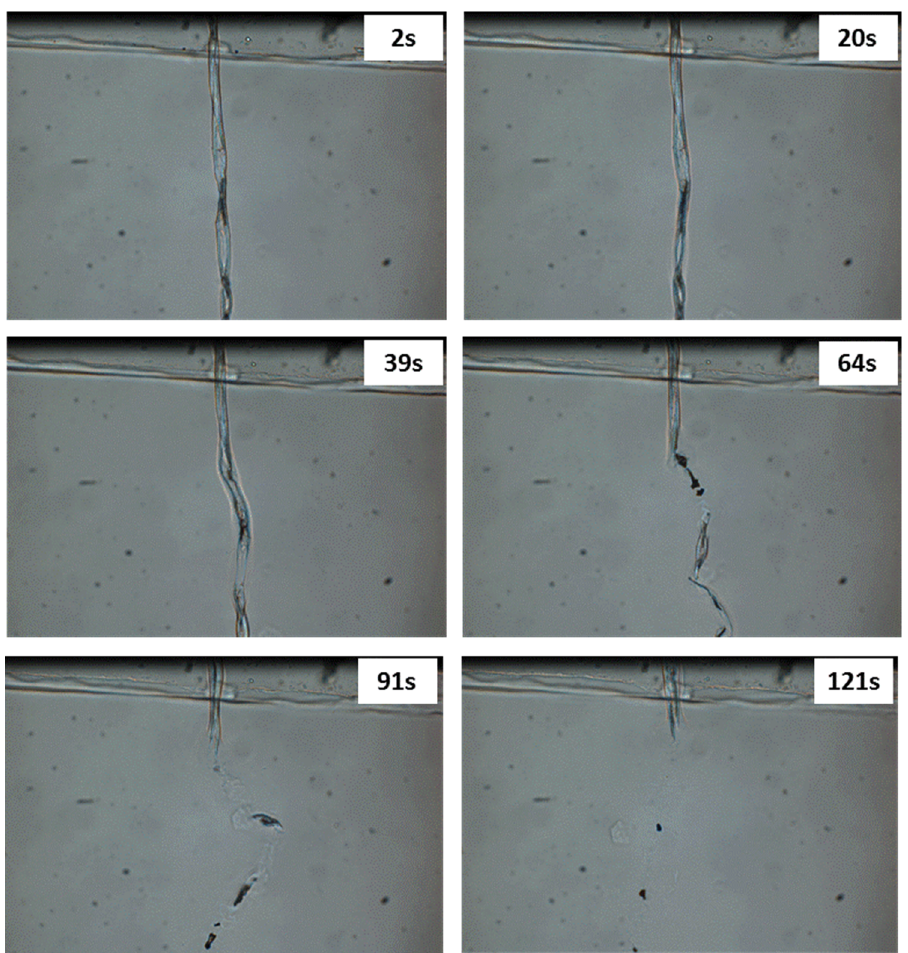
Figure 2. Optical microscopy pictures of the dissolution of a single cotton fiber in [DIMIM][(MeO)(H)PO 2 ] at 80 °C .